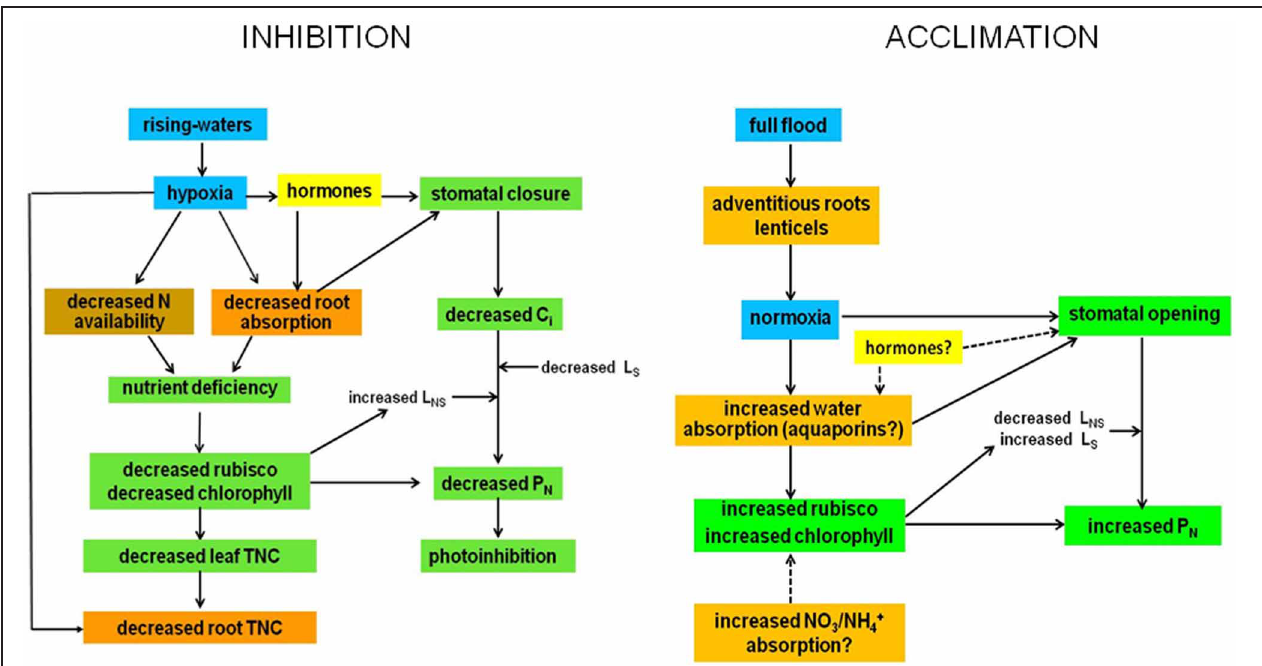
FIGURE 4 | Possible mechanisms of inhibition and acclimation of photosynthesis by flooding. Blue, water; brown, soil; orange, roots and stems; green, leaf; yellow, undetermined.